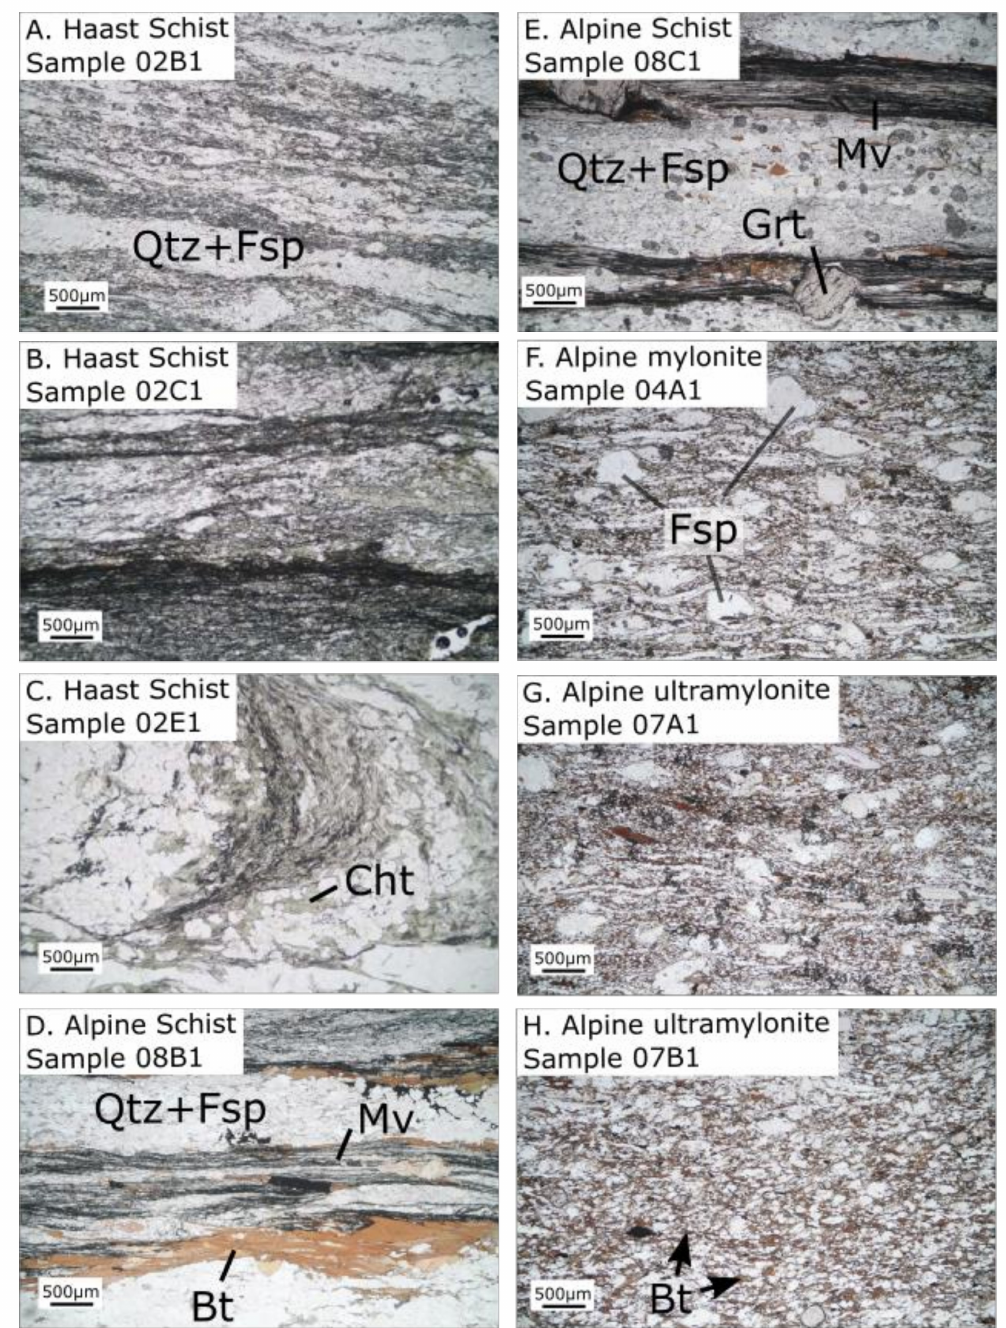
Figure 2. Photomicrographs illustrating mineralogy and microstructures of Haast Schist ( A – C ), Alpine Schist ( D , E ), Alpine mylonite ( F ), and Alpine ultramylonite ( G , H ) samples. These are pre- sented in order of increasing metamorphic grade, strain, and decreasing distance to the Alpine